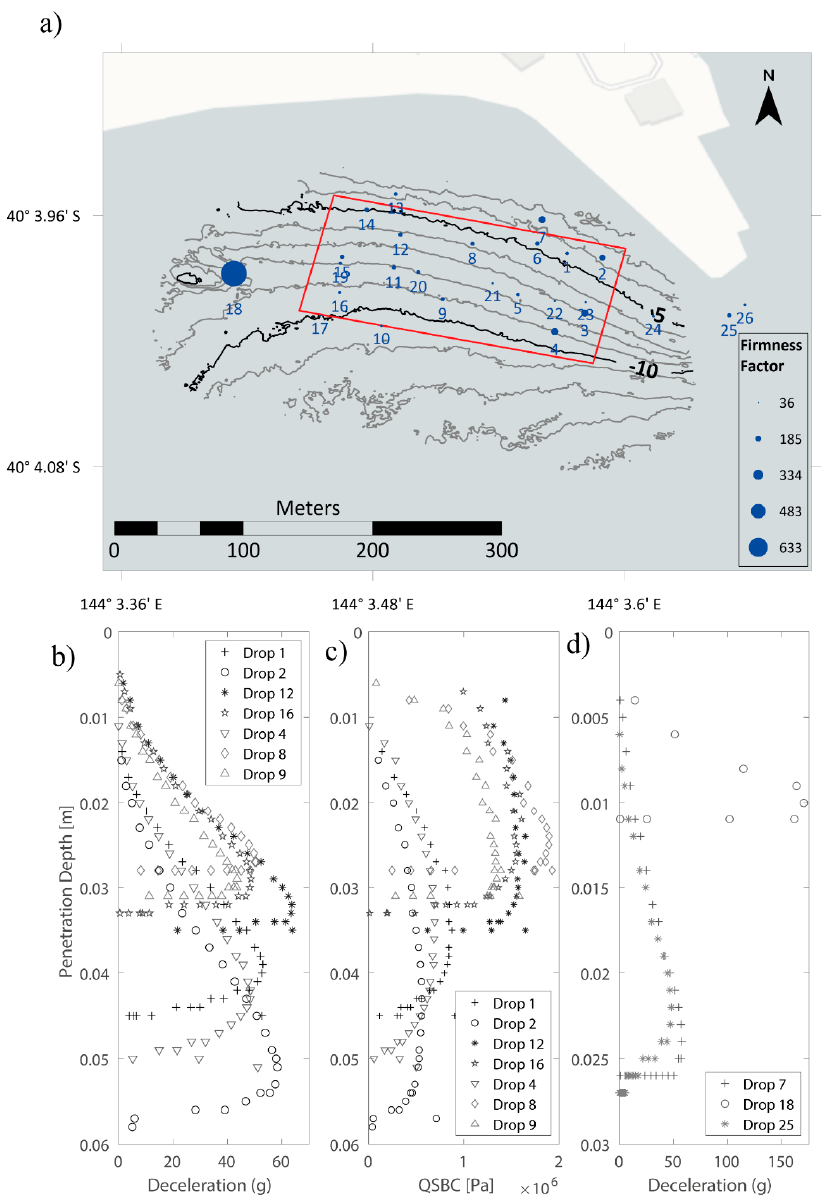
Figure 5. ( a ) Location and firmness factor (FF) of penetrometer casts for the surficial sediment strength survey. Marker size refers to magnitude of the firmness factor. Generally, harder substrate is found along the edges of the surveyed area. Target area is marked by the red line. ( b ) Deceleration curves from selected penetrometer drops across the target area. ( c ) Quasistatic bearing capacity (QSBC) profiles from the same selected casts shown in ( b ). ( d ) Deceleration curves for profiles taken outside of the target area showing casts near the rockwall (drops 7 and 25) and over a rocky underwater outcrop (drop